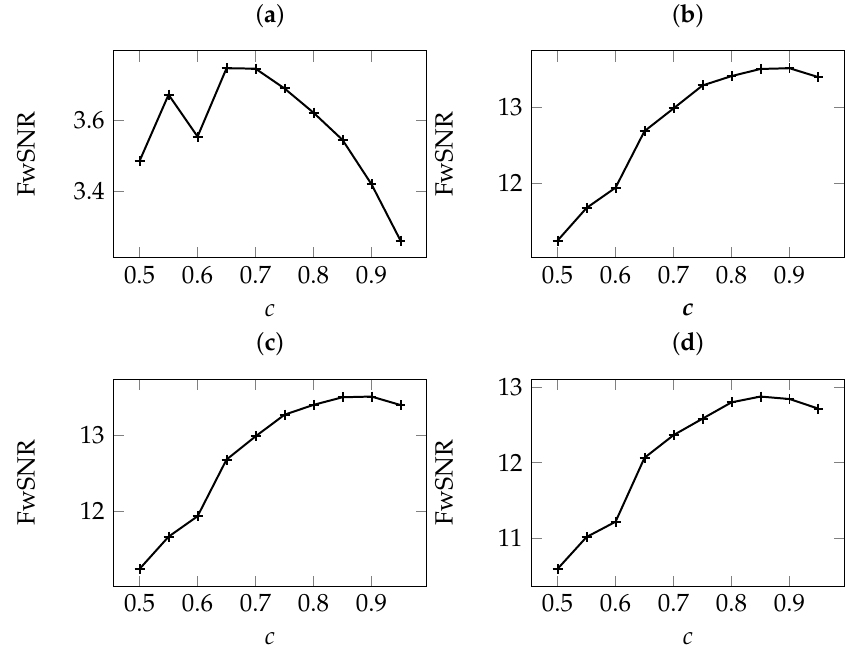
Figure 5. The performance of the proposed method (frequency-weighted segmental SNR (FwSNR)) when the adaptation speed c is varied for various communication channels: ( a ) GSM, ( b ) IMA-ADPCM, ( c ) PCM, and ( d ) Microsoft-ADPCM.. The results are the average FwSNR over all 20